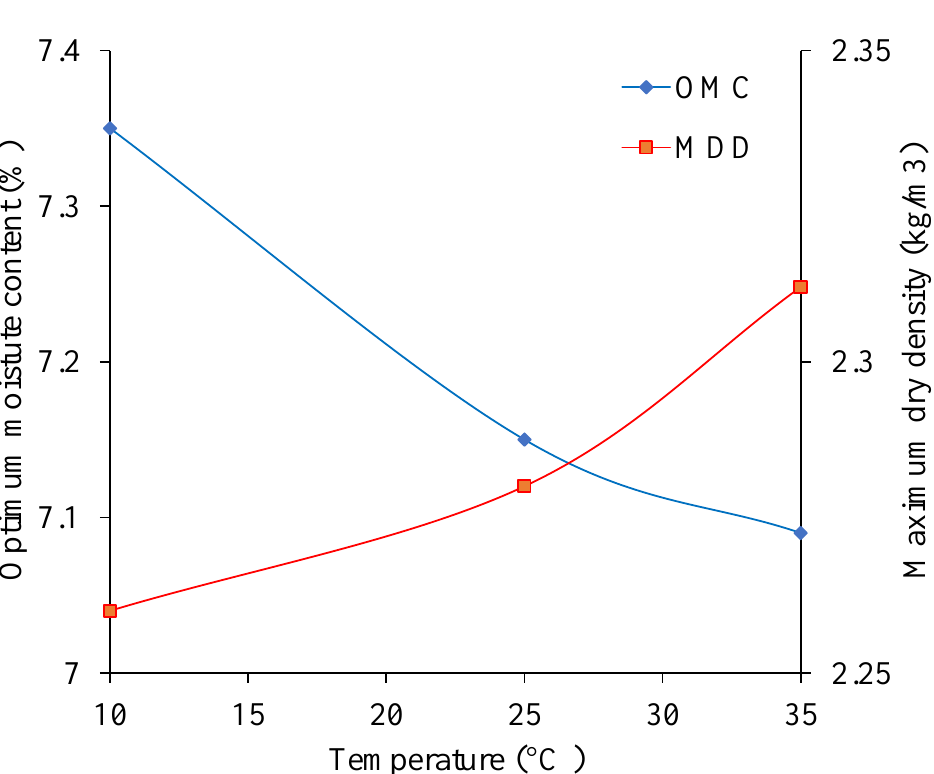
Figure 8. The influence of temperature on the compaction results.